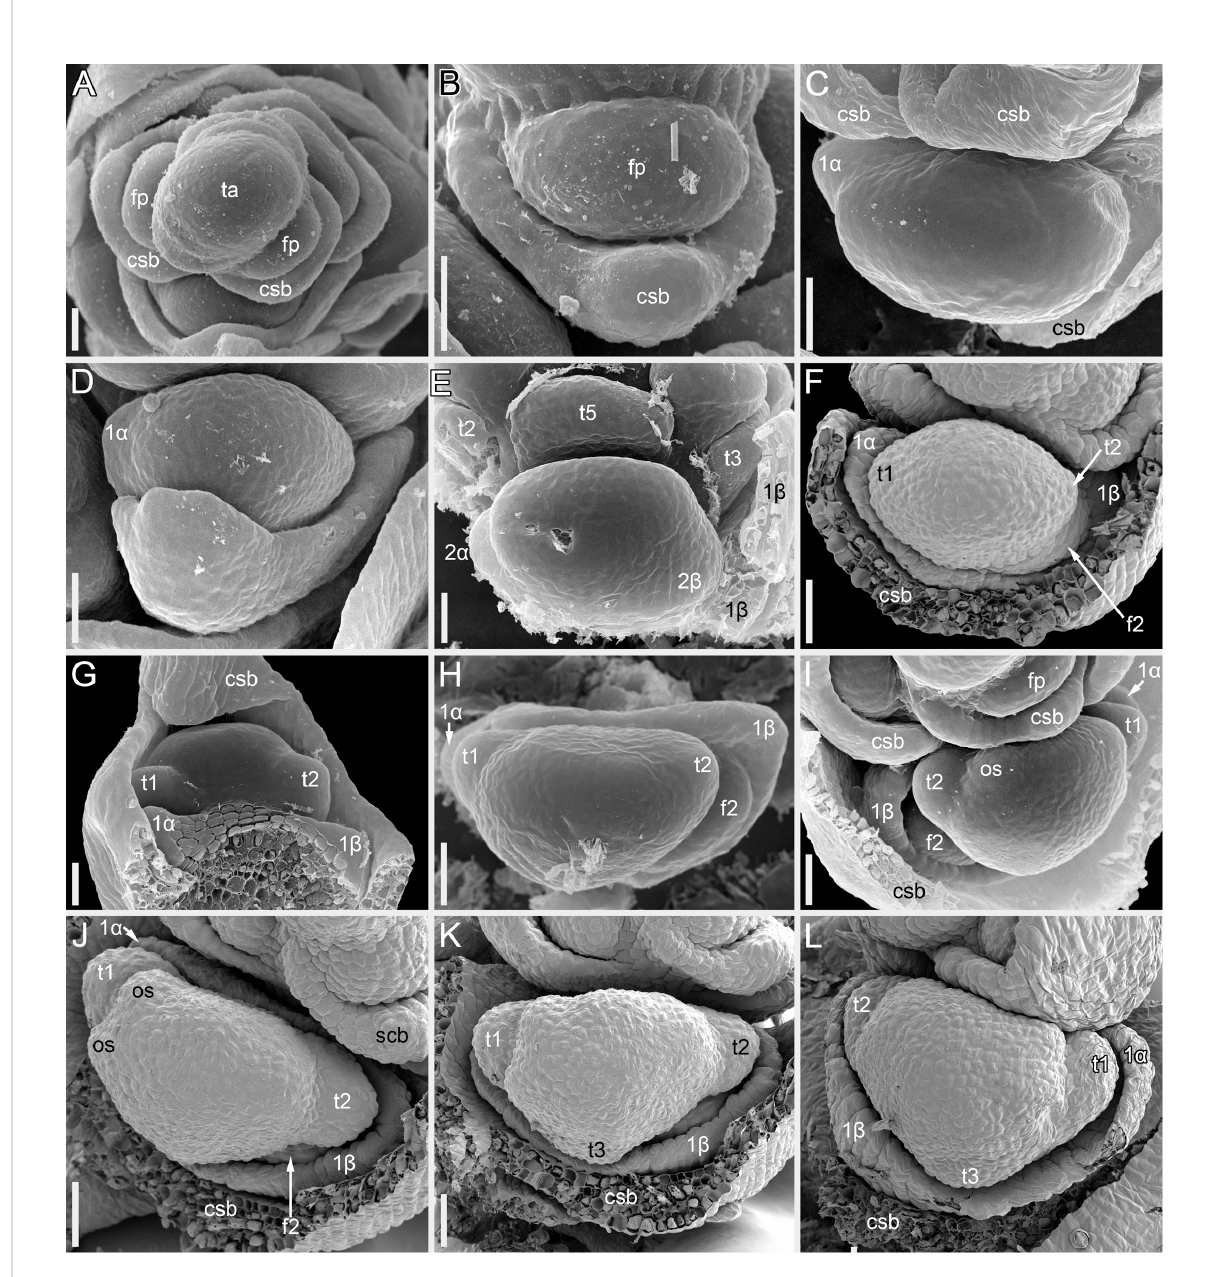
FIGURE 2 Flower development in Fagopyrum esculentum , stages 1 – 4 (SEM). (A, B) Stage 1. (A) Thyrse apex with spirally arranged cyme-subtending bracts and primordia of fi rst fl owers of cymes in their axils. (B) Primordium of the fi rst fl ower of a cyme. (C – E) Stage 2. (C, D) The fi rst fl ower of a cyme. (E) The second fl ower of a cyme. (F – H) Stage 3. (F) Cyme in abaxial view, cyme-subtending bract partly removed; early stage 3 with tepals 1 and 2 just slightly recognizable. (G) Cyme in adaxial view. (H) Cyme in top view, abaxial side down. (I – L) Stage 4. (I, L) Flowers that differ in handedness from the fl ower in (J, K) . (J, K) Different views of the same fl ower to show fusion of the two prophylls to form a tube (prophyllar sheath). (A, E) Chatyr Tau. (B, C) Temp. (D) Batyr. (F, J – L) Dasha. (G) Dozhdik. (H, I) FAD_F2_2018. 1 a , 1 b , prophylls of the fi rst fl ower of a cyme; 2 a , 2 b , prophylls of the second fl ower of a cyme; csb, cyme-subtending bract; f2, the second fl ower of a cyme; fp, fl ower primordium; os, outer whorl stamen; t1-t5, tepals in in order of their inferred (pre)patterning; ta, thyrse apex. Scale bars = 30 µm (A – L)